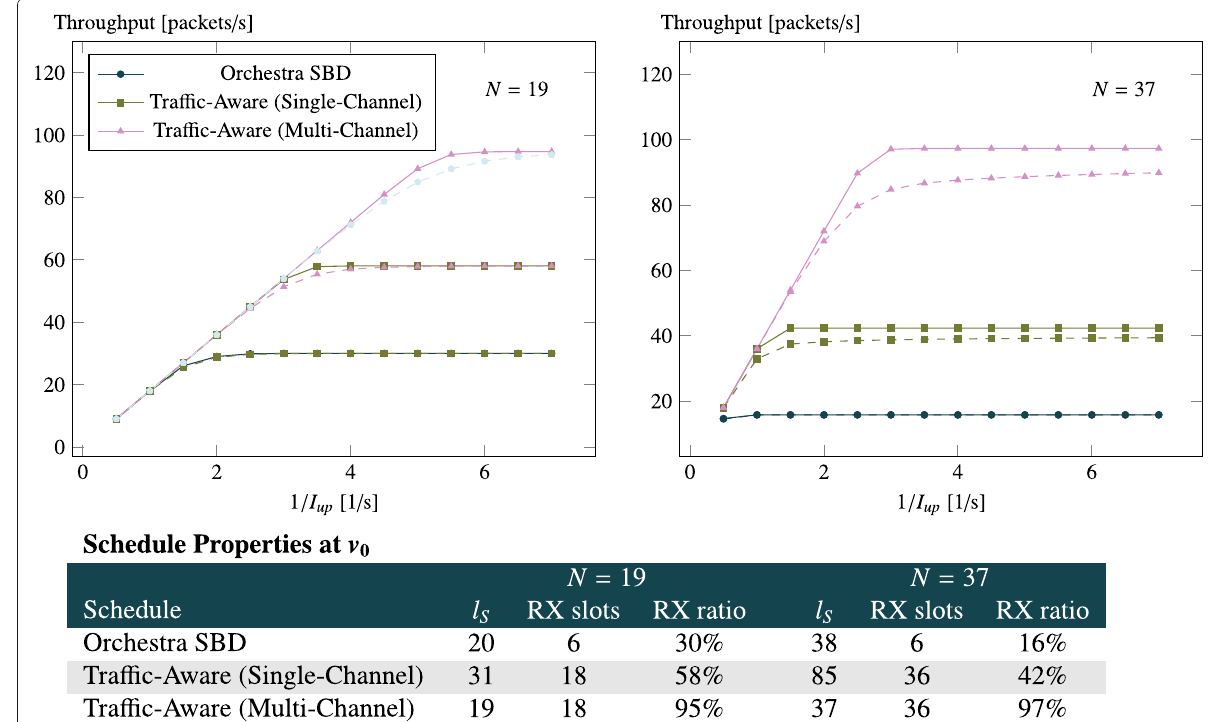
Fig. 13 Throughput for the Sender-based Dedicated Orchestra Schedule and the two presented traffic-aware schedules over the packet sending interval for a network of N = 19 and N = 37 nodes aligned in concentric circles. The solid lines are for K = 16, the dashed for K = 6. In addition, the table presents schedule properties at the root node v 0